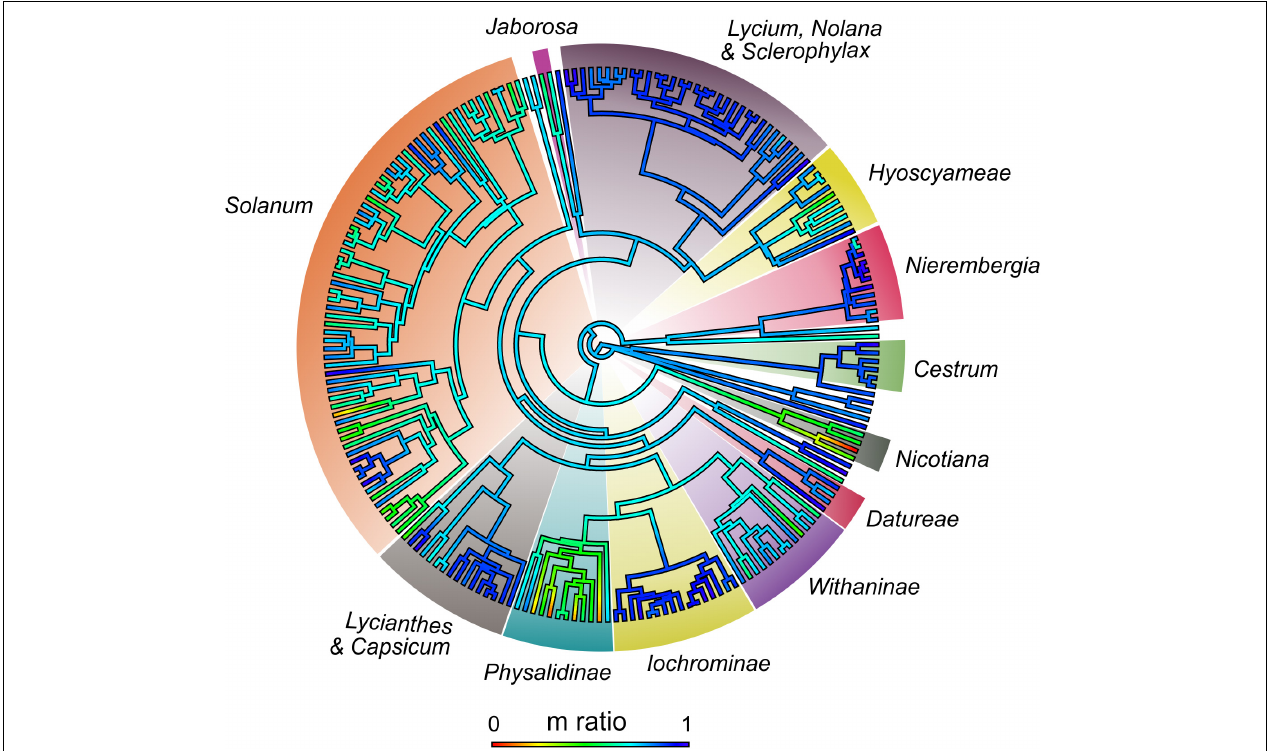
FIGURE 2 | Heatmap of m ratio (proportion of metacentric chromosomes over the total chromosomes of each karyotype formula) reconstructed on Solanaceae. Scale below indicates values of the ratio and its color guide. Values vary from 0 (no metacentric chromosomes) to 1 (all chromosomes